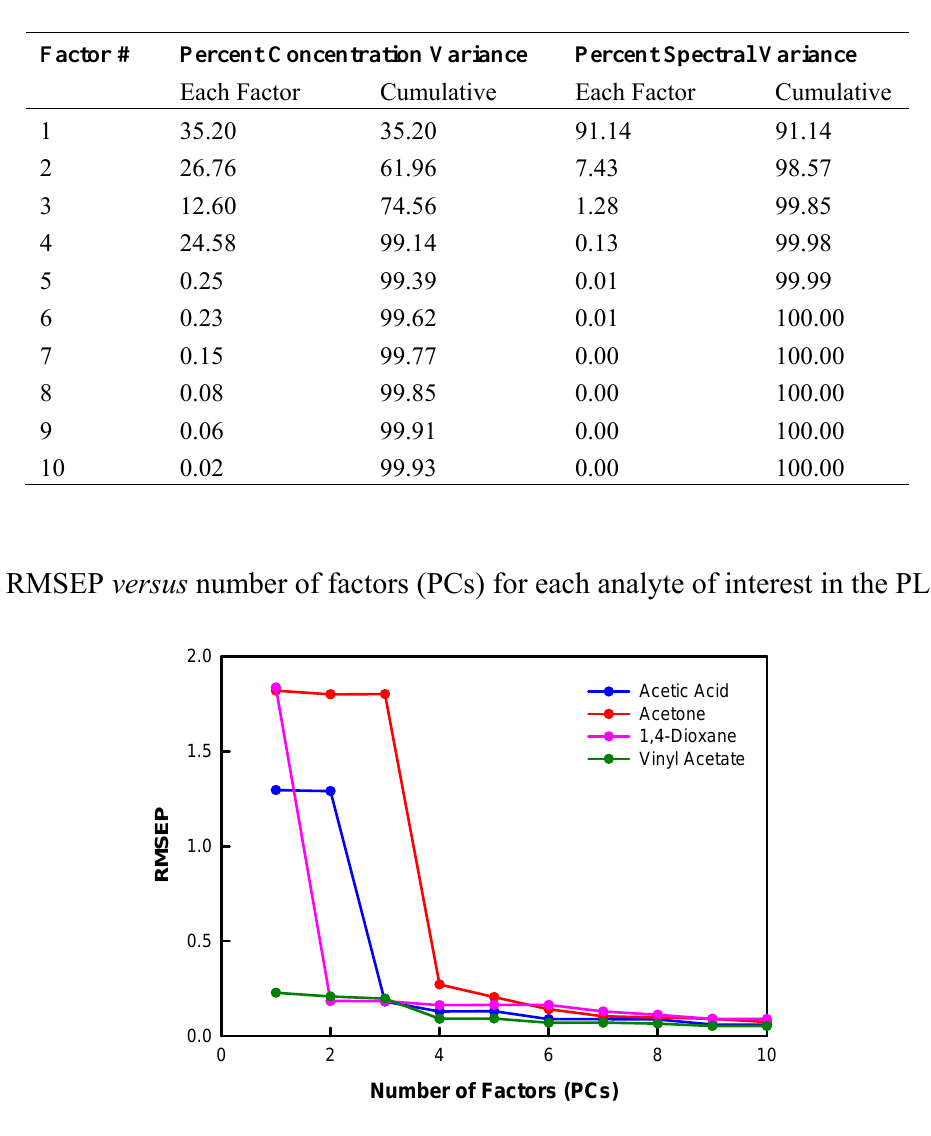
Table 2. Percent variance for the PLS2 model.